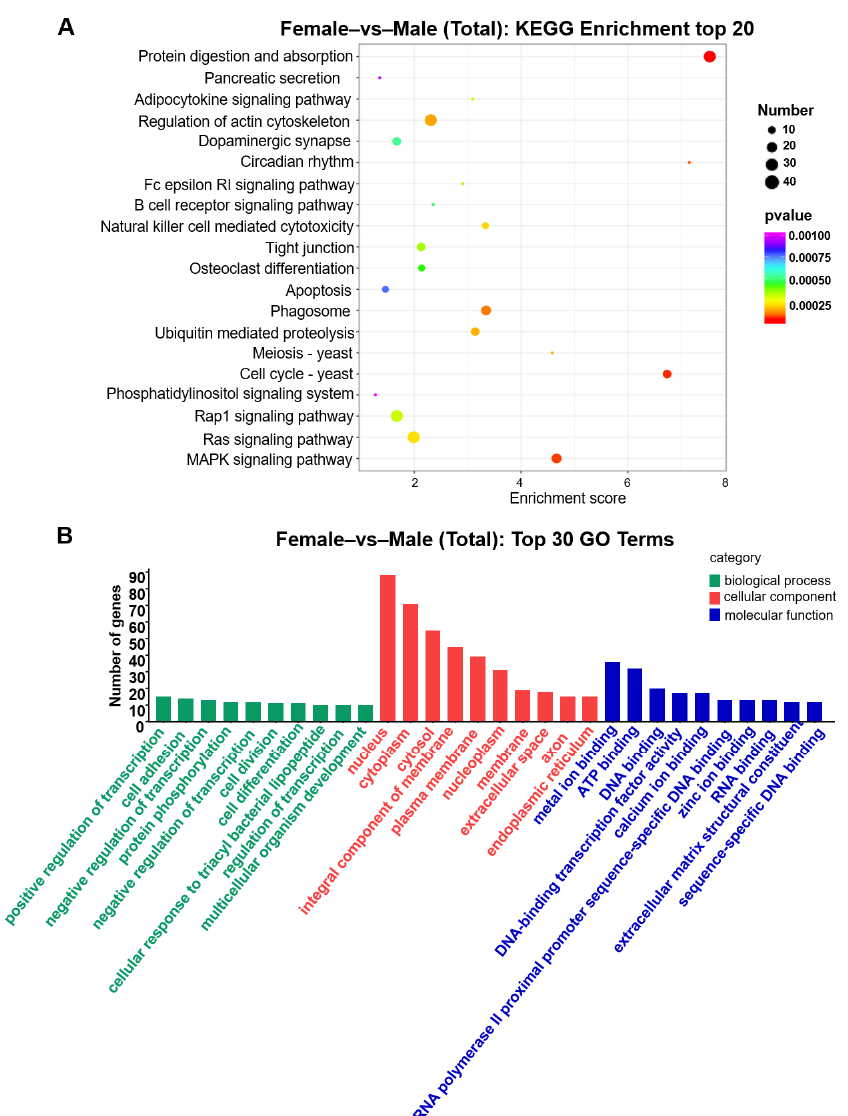
Figure 3. GO and KEGG analysis of target genes. ( A ) Bubble diagram of KEGG enrichment analysis. The smaller the p -value, the more distinctive the red color. The bigger the point is, the more genes are enriched in the pathway. ( B ) GO enrichment analysis. Top 30 GO terms of genes targeted by DEMs from A. fasciatus gonads. The result was divided into three categories: biological process, molecular function, and cellular